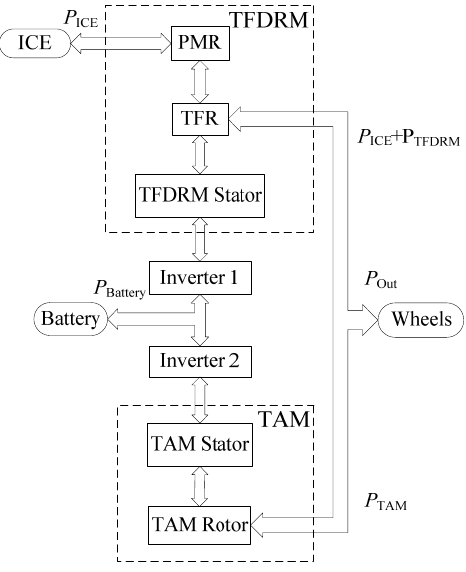
Figure 2. Energy flow in the CS-TFPMSM